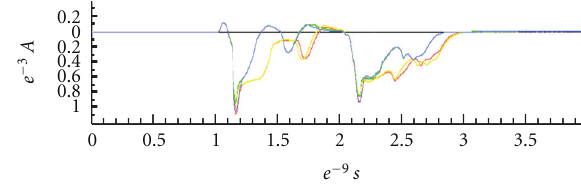
Figure 16: Current profiles of Figure 8 DES submodule block implemented on a standard model FPGA.